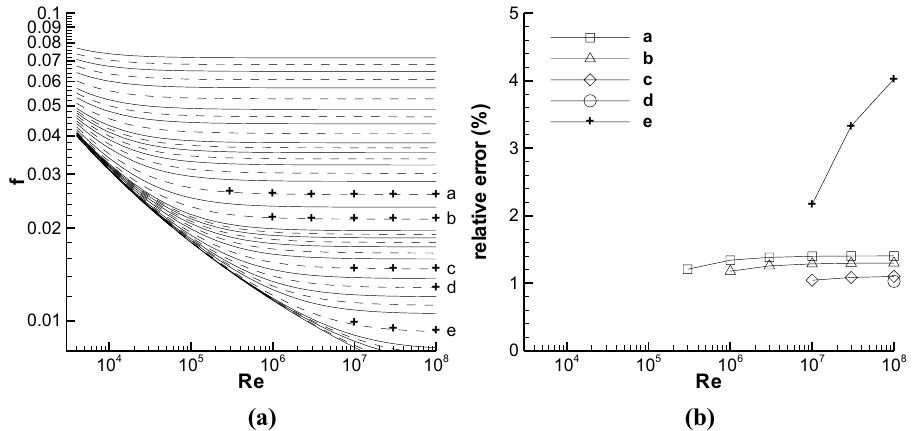
Figure 3. ( a ) The plus symbols denote the locations where the relative errors of the f s at the pseudo-midpoint ε/ ds in comparison with those at the corresponding midpoint ε/ds are larger than 1%. The nineteen corresponding pseudo-midpoint ε/ds of the dashed lines are 0.0447, 0.0346, 0.0245, 0.0173, 0.0122, 0.0089, 0.0069, 0.0049, 0.0028, 0.0014, 8.94 × 10 −4 , 6.93 × 10 −4 , 4.9 × 10 −4 , 2.83 × 10 −4 , 1.41 × 10 −4 , 7.07 × 10 −5 , 2.24 × 10 −5 , 7.07 × 10 −6 , and 2.24 × 10 −6 from the top to the bottom. ( b ) The relative errors of the f s at five pseudo-midpoint ε/ds, i.e. ε/d = 0.0028, 0.0014, 2.83 × 10 −4 , 1.41 × 10 −4 , and 2.24 × 10 −5 , respectively, from alphabet a–e.